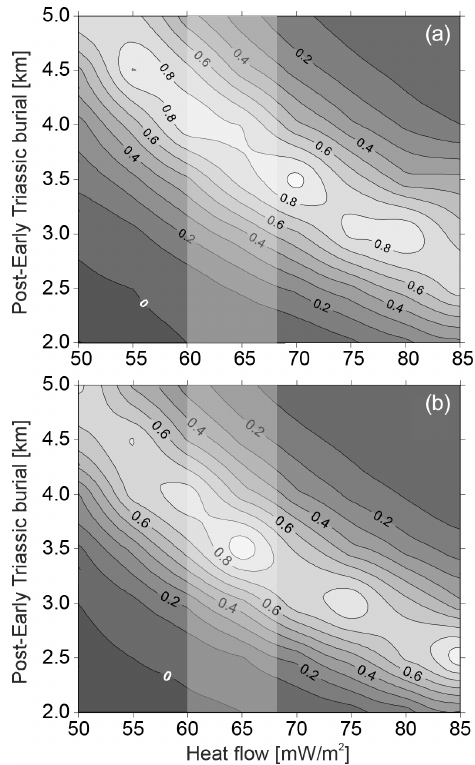
Figure 10. Modelled relations between heat flow and the thickness of the missing sequence. The plots were generated by running 56 combinations of assumed heat flow and cover sequence thicknesses using PetroMod (Schlumberger) and HeFTy (Ketcham, 2005) soft- ware. The isolines represent the goodness of fit (GoF) calculated according to the apatite fission-track ages measured on the Lower Triassic Bunter sandstone samples V-27 from the Thuringian For- est (a) and V-144 from the WFW region (b) . A high GoF value (max = 1) indicates a good match between the measured and calcu- lated values. The burial and exhumation trends applied for the burial modelling follow the observed characteristics obtained by the ther- mal modelling of the Thuringian Forest and WFW samples. In case (a) the inflexion of the thermal history was set to 90Ma, followed by rapid and then decreasing cooling, while in case (b) the inflex- ion is set to 75Ma and the cooling rate is kept constant until the Eocene (see text and top right panels in Fig. 9). The light verti- cal band represents a most likely heat flow of 60 to 68mWm − 2 . The corresponding burial amounts to 3.5 to 4km, which is actually undistinguishable for the two modelled